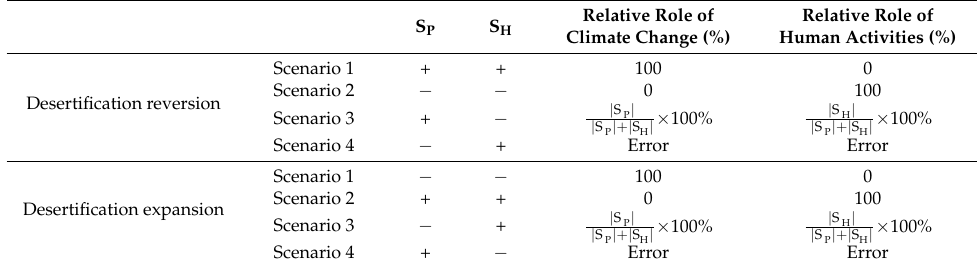
Table 1. Scenarios for assessing the roles of climate change and human activities in desertification.